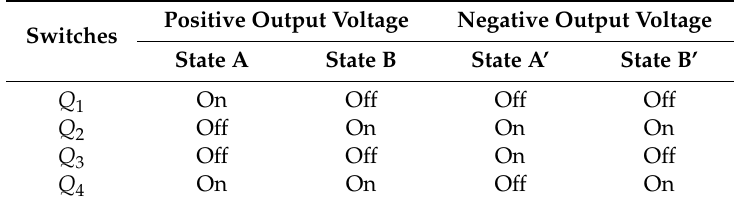
Table 3. Switching states of semiconductor devices.